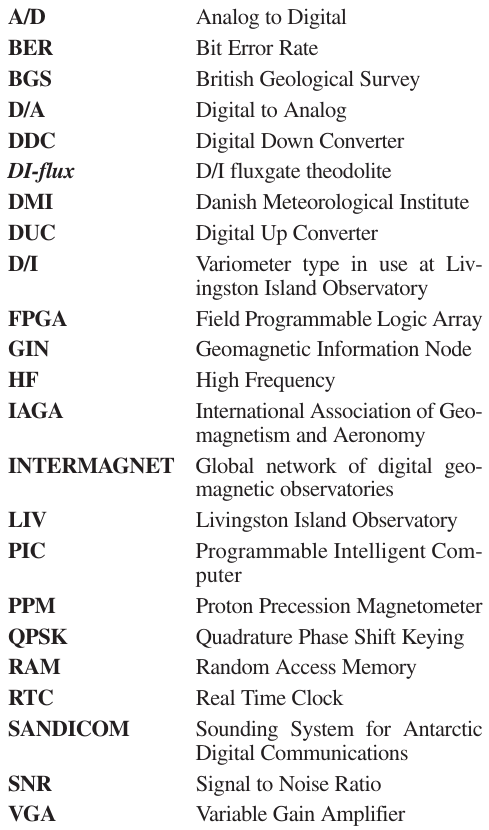
Table I. Acronym